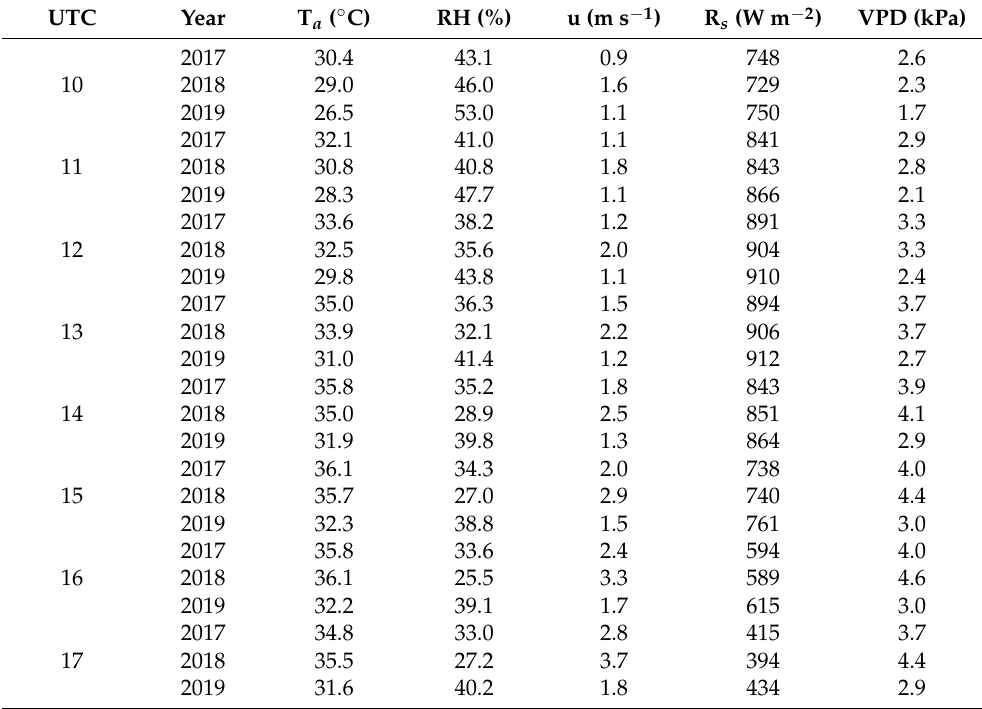
Table 3. Hourly mean climatic conditions over the periods (expressed in days of the year, DOY) 206–217 (2017), 207–231 (2018) and 172–211 (2019). T a : air temperature, RH: relative humidity, u: wind speed, R s : solar radiation, VPD: vapor pressure